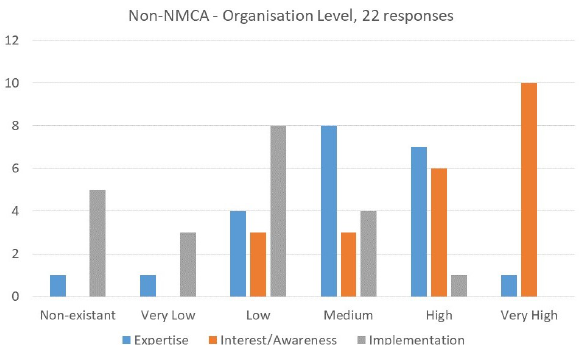
Figure 2: Levels of interest, expertise and implementation of Digital Twins - Organisation Level - Non-NMCA Respondents